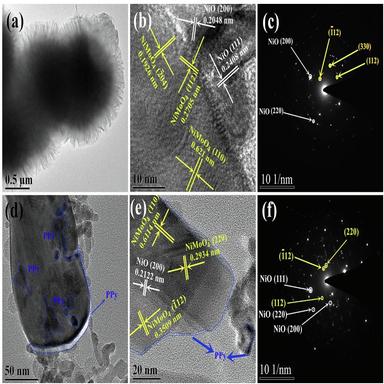
(Color online) TEM image (a, d), HRTEM image (b, e) and SAED pattern (c, f) of NiO@NiMoO4 (a–c) and NiO@NiMoO4@PPy (d–f).